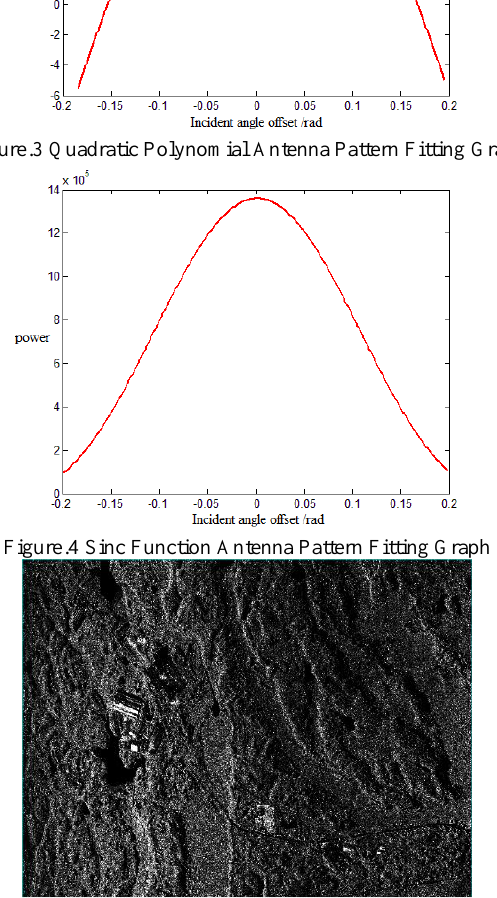
Figure.5 Antenna pattern corrected